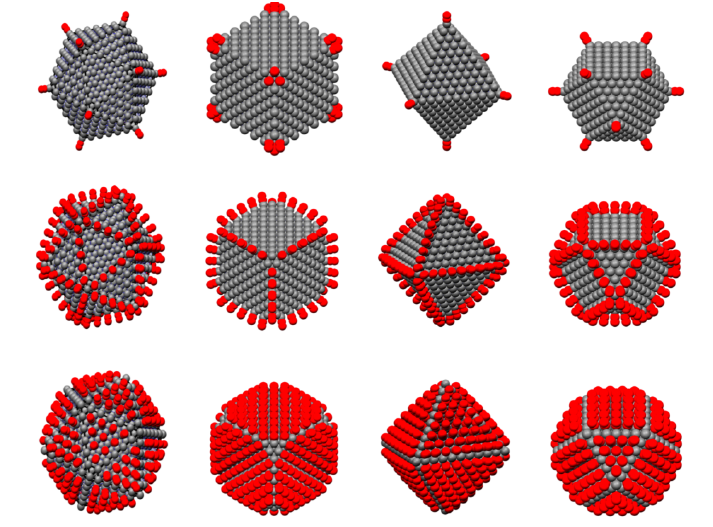
Figure 1. Kink ( row 1 ), edge ( row 2 ), and facet ( row 3 ) bonding of O 2 to platinum